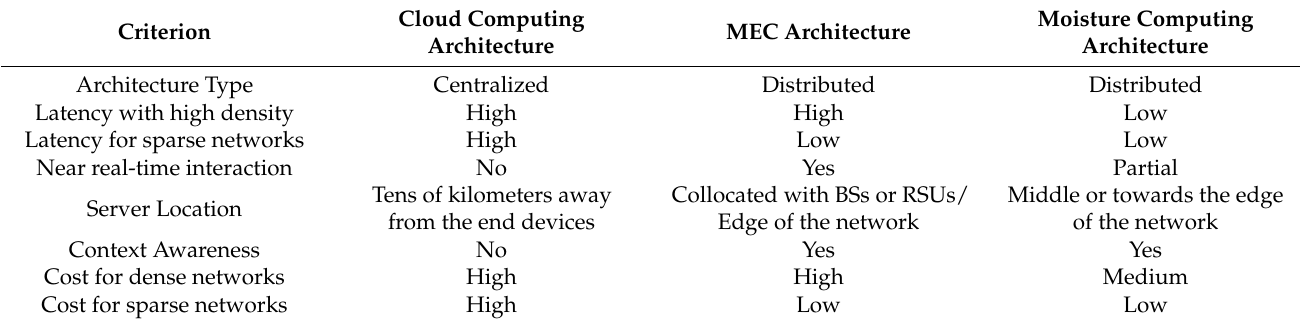
Table 3. The key criteria of mobile edge computing (MEC), cloud computing, and MC